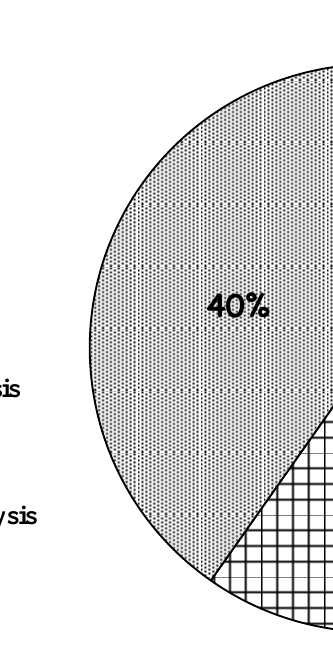
Figure 5. Systematic review by study methods/approach.